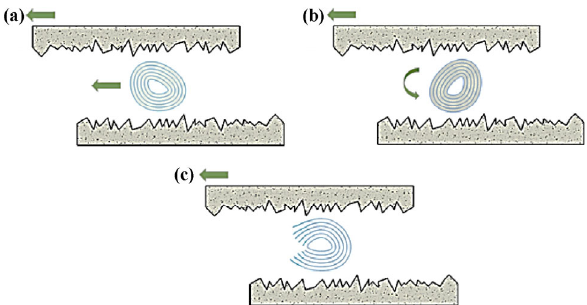
Fig. 10 Three main friction mechanisms of multilayered IF NP: